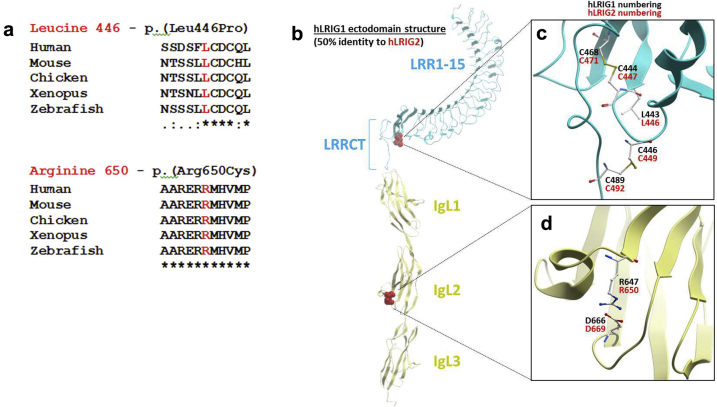
Leucine-rich repeats and Ig-like domains 2 (LRIG2) missense variants. (a) Conservation of Leu446 and Arg650 between human, mouse, chicken, xenopus, and zebrafish protein sequences. An asterisk indicates positions which have a single, fully conserved residue; a colon indicates conservation between groups of strongly similar properties, scoring >0.5 in the Gonnet point accepted mutation 250 matrix; a period/full stop indicates conservation between groups of weakly similar properties, scoring <0.5 in the Gonnet point accepted mutation 250 matrix. (b) Extracellular domains of human LRIG1 (hLRIG1) that has approximately 50% sequence similarly to human LRIG2. Leucine-rich repeats (1–15) and Ig-like domains (1–3) are depicted. (c,d) These 2 frames show details of the regions containing the Leu446Pro (L446) and the Arg650Cys (R650) LRIG2 missense variants, respectively.